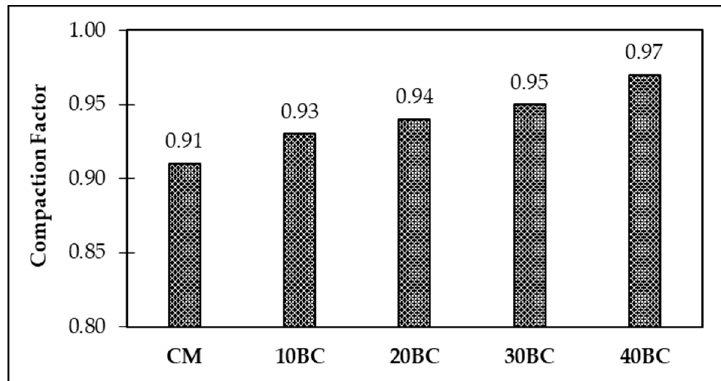
Figure 5. Compaction factor values of different concrete mixes.